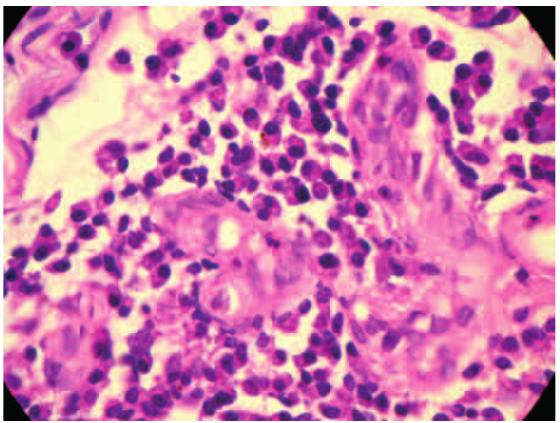
Figure 2. Intravascular large B-cell lymphoma – hematoxylin and eosin stain (original magnifi cation x 600)